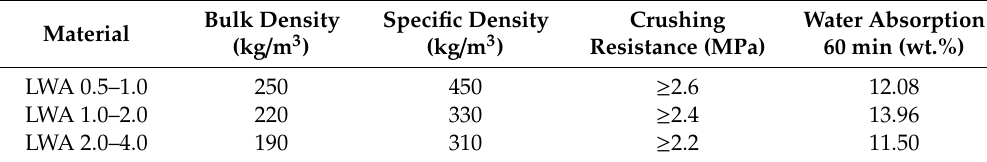
Table 2. Measured physical properties of the lightweight aggregate (LWA).